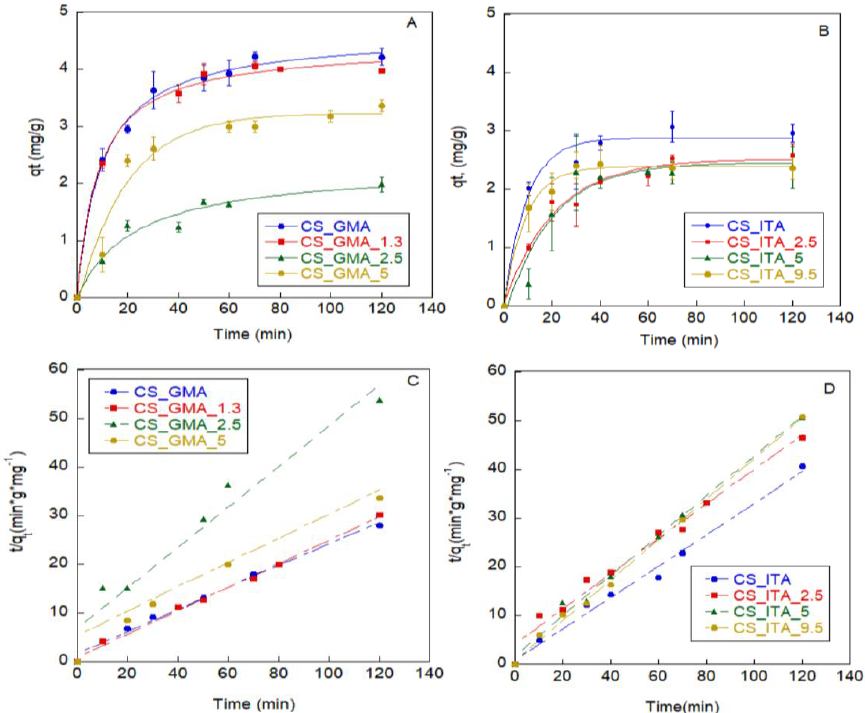
Figure 9. Adsorption kinetics of 2,4-D on CS_GMA ( A ) and CS_ITA ( B ) MIPs and NIPs; ( C ) pseudo- second-order model for CS_GMA and CS_GMA_X samples; ( D ) pseudo-second-order model for CS_ITA and CS_ITA_X samples.